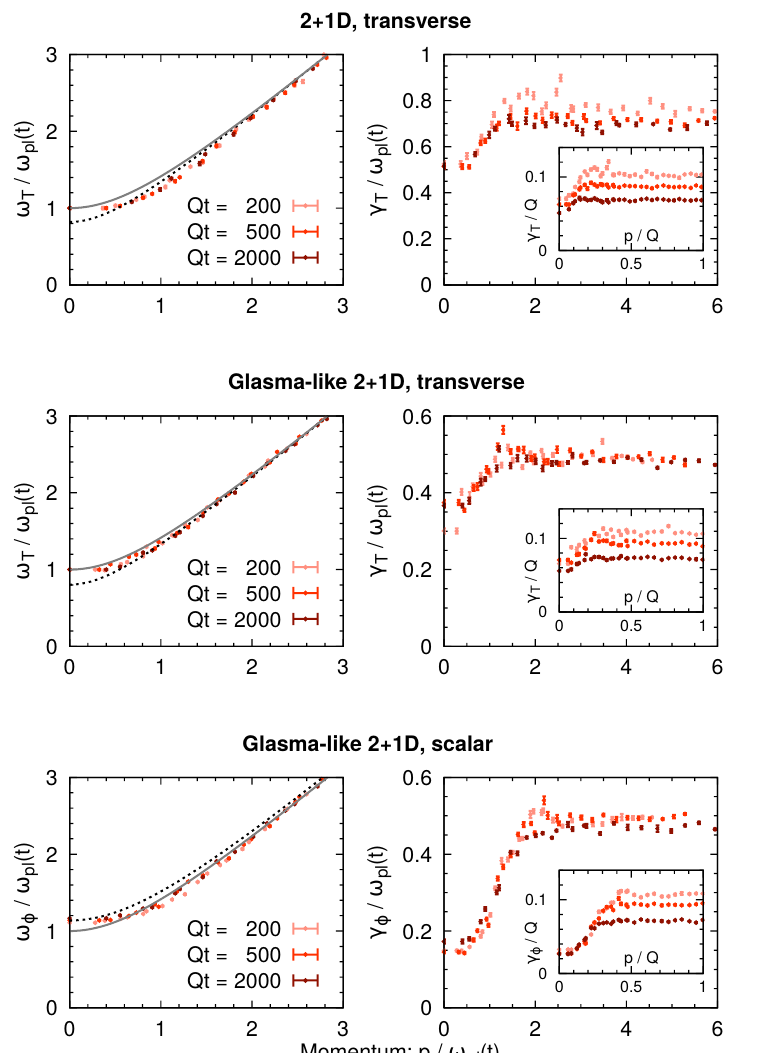
Figure 9 . The peak position (dispersion relation) ω α ( t, p ) and the peak width (damping rate) γ α ( t, p ) as functions of momentum p at different times for ( top :) the transversely polarized gluons of the usual 2 + 1 -dimensional theory and for ( center :) the transversely polarized gluons and ( bottom :) the scalar correlator of the Glasma-like 2 + 1 -dimensional theory. Dispersion relations, widths and momenta are normalized by the time dependent mass scale ω ( t ) in the main plots and pl by the time independent energy scale Q in the insets. Additionally, we show, in the left panels, the same HTL dispersion relations ω HTL ( p ) and relativistic dispersions ω ( p ) as in figure 1 as black rel T/φ dashed and continuous gray lines,